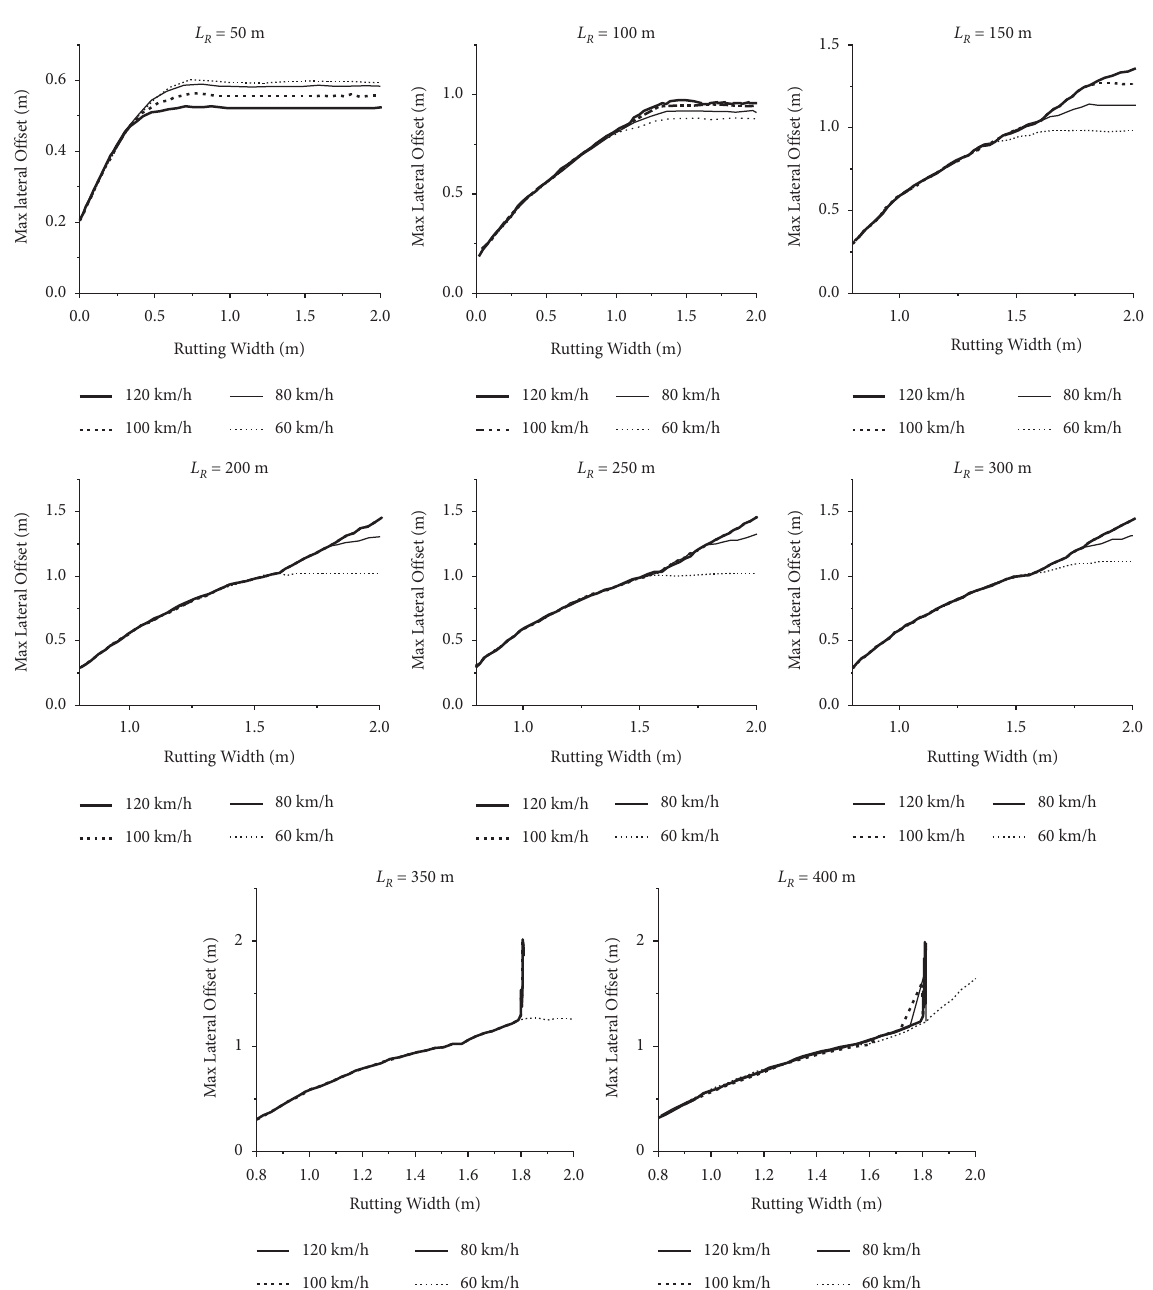
Figure 13: Maximum lateral offset at different combinations of water length and width ( L